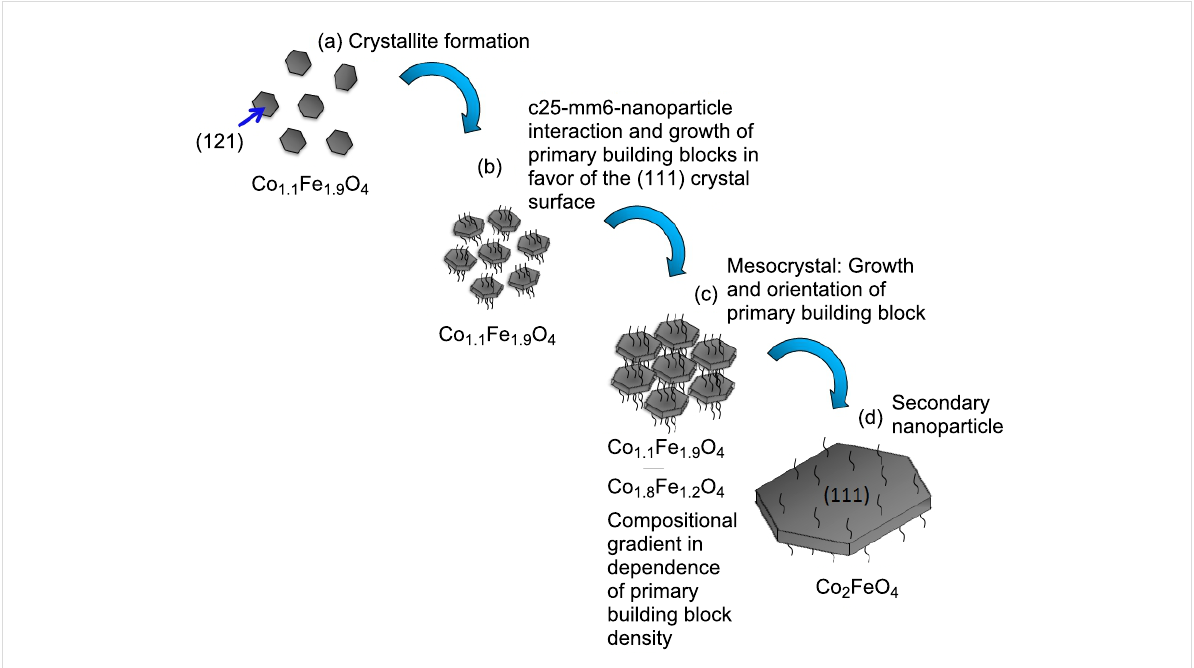
Figure 5: Schematic of nanoparticle formation during the biomimetic growth process. (a) Crystallites are formed, (b) c25-mms6 interacts with the crystallites which then grow into primary building blocks. (c) The primary building blocks assemble and reorient along a common crystallographic axis. (d) The primary building blocks aggregate to form the secondary